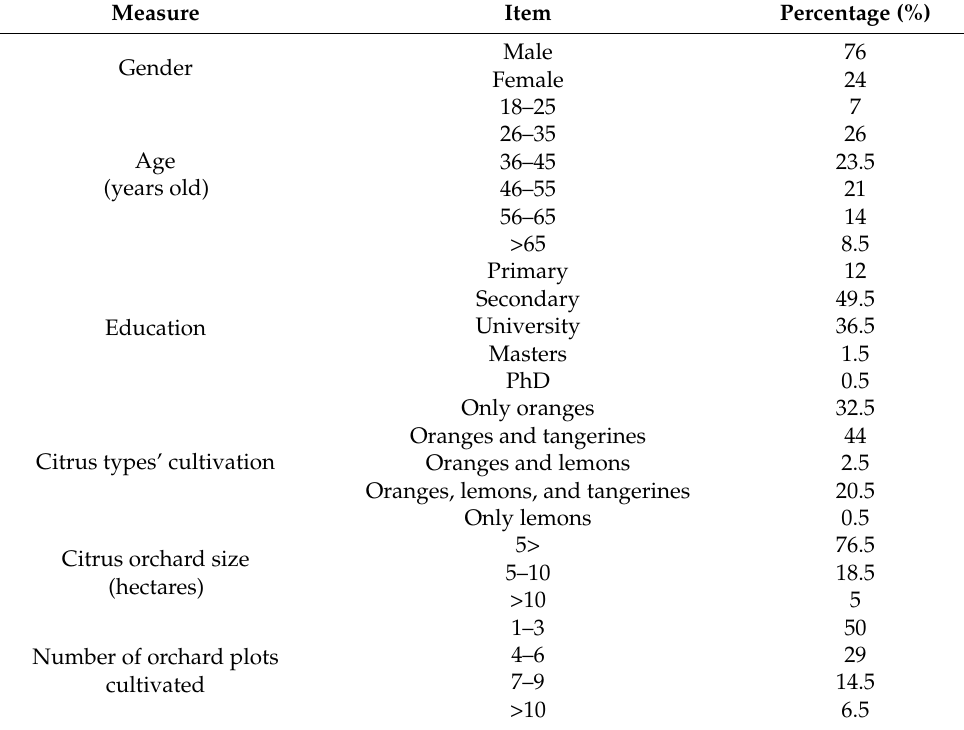
Table 1. Citrus growers’